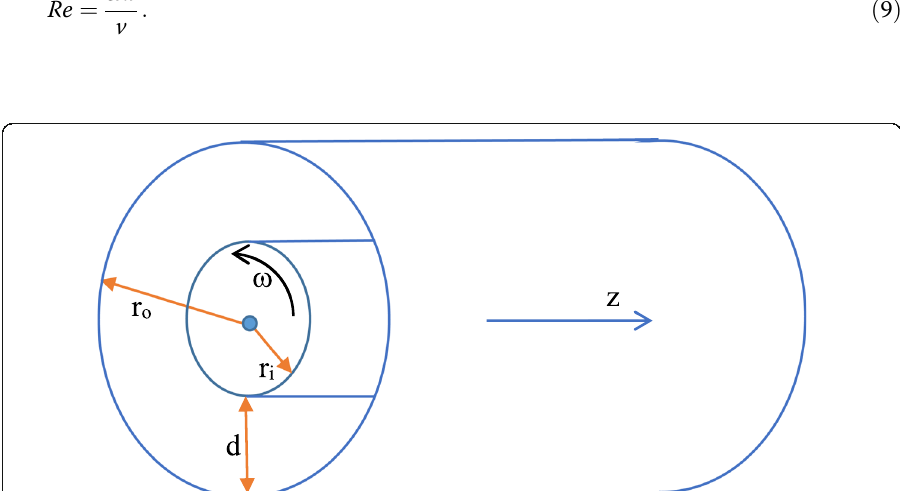
Fig. 1 Schematic of the Taylor-Couette